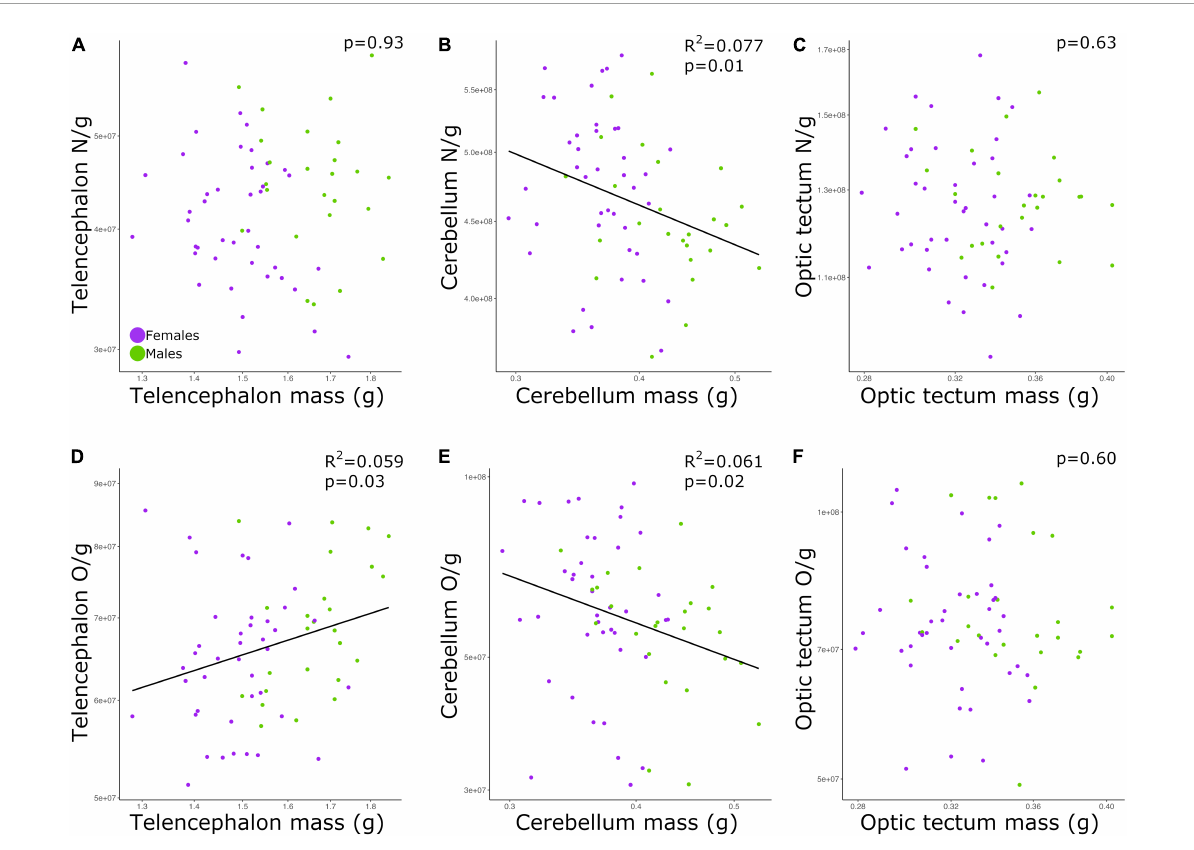
FIGURE3 Scatterplots of (A) neuronal density in the telencephalon against telencephalon mass, (B) neuronal density in the cerebellum against cerebellum mass, (C) neuronal density in the optic tectum against optic tectum mass, (D) non-neuronal density in the telencephalon against telencephalon mass, (E) non-neuronal density in the cerebellum against cerebellum mass, (F) non-neuronal density in the optic tectum against optic tectum mass. In all graphs, males are shown in green, and females are shown in purple. N/g, neuronal density; O/g, non-neuronal